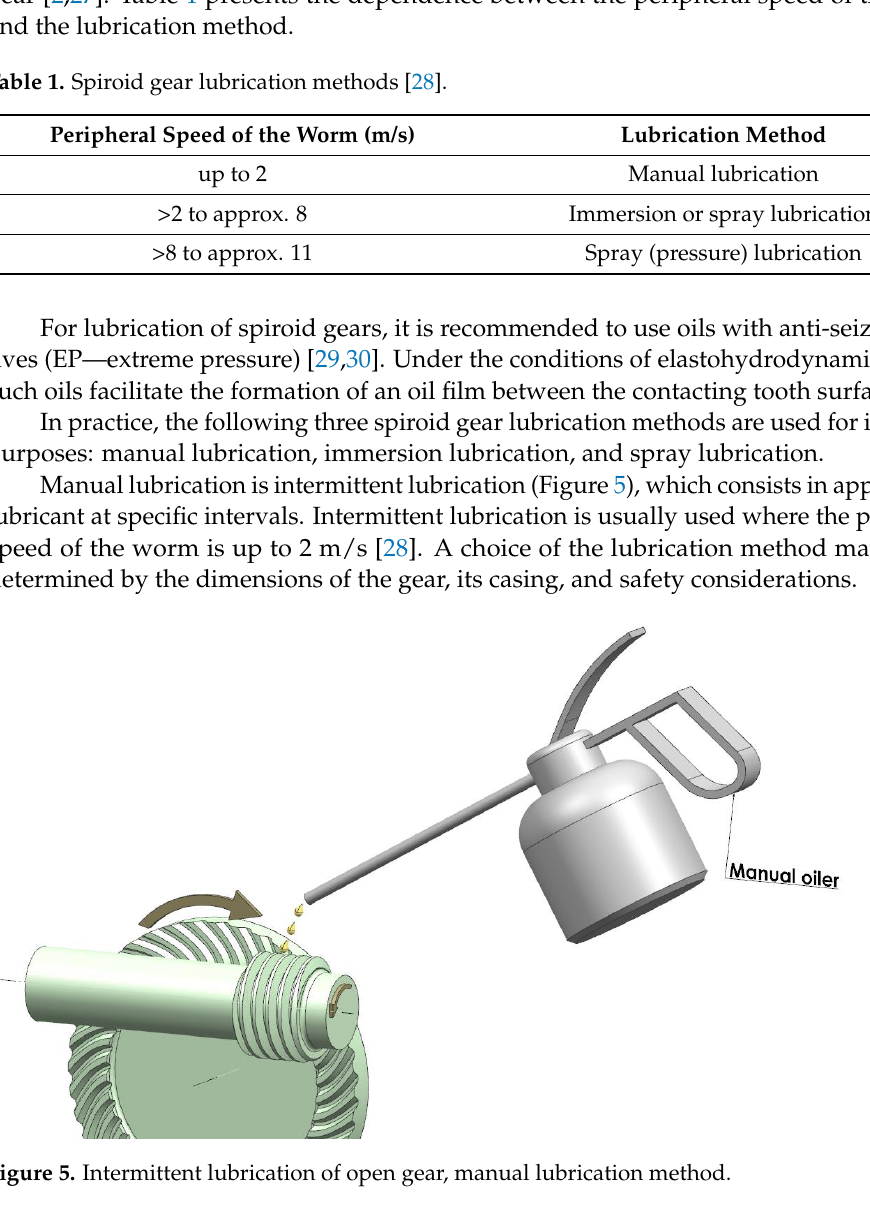
Figure 6. Immersion lubrication of spiroid gear; 1 — face gear, 2 — worm, 3 — casing, and 4 — oil. Immersion lubrication uses the rotation of the worm and face gear immersed in oil. The worm tooth should be immersed in oil to the depth of  3 m , where “m” is the normal module. The rotating input shaft delivers oil to the mating worm threads and the worm wheel teeth. The splash delivers oil to the rolling bearings. Where the peripheral speed of the worm exceeds 8 m/s, the spray lubrication method should be used (Figure 6) [29].